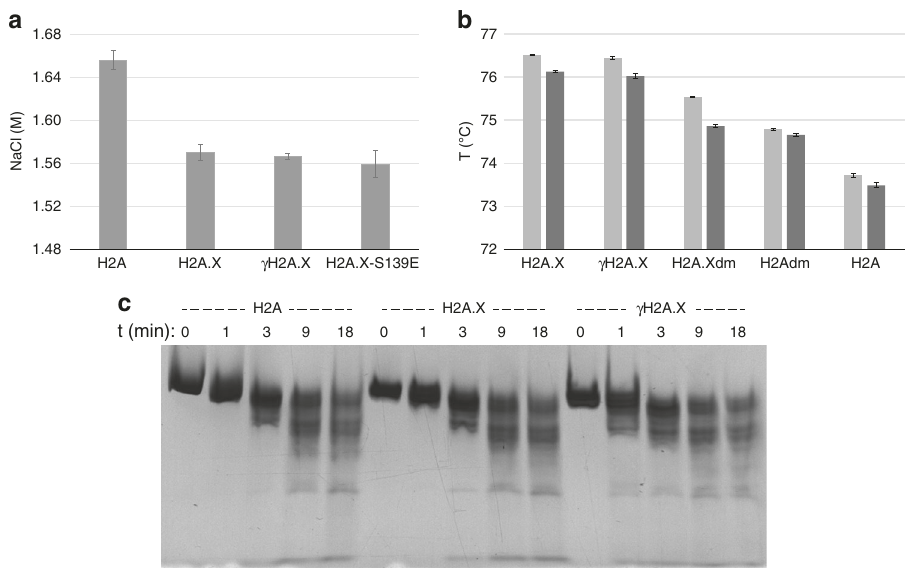
Fig. 4 H2A and H2A.X nucleosomes display distinct stability/dynamics characteristics. a Salt-induced histone – DNA dissociation measured by tyrosine fl uorescence spectroscopy (mean ± s.d., n = 2, 3, 3, 2 independent experiments). b High temperature-induced histone – DNA dissociation based on either hydrophobic dye binding fl uorescence (light grey) or DNA denaturation (dark grey; mean ± s.d., n = 2 independent experiments). c Micrococcal nuclease digestion analysis of H2A-NCP, H2A.X-NCP and γ H2A.X-NCP. After incubation with nuclease for the speci fi ed times, samples were visualized by native DNA PAGE subsequent to degradation of proteins. A digest pro fi le together with a 10 bp DNA ladder is shown in Supplementary Fig. 6. Source data are provided as a Source Data fi